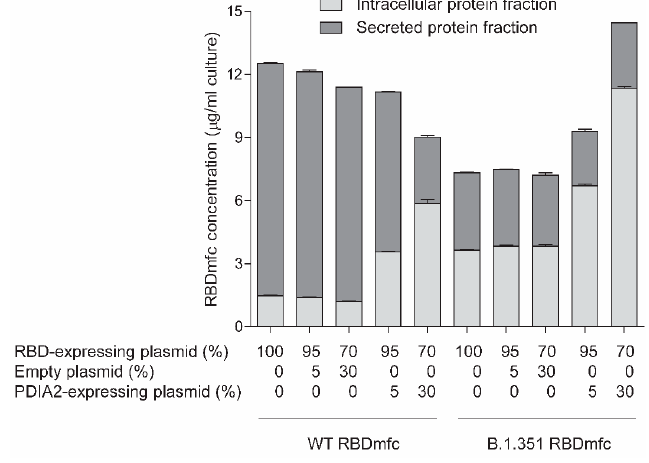
Figure 3. Concentration of intracellular and secreted recombinant RBDmfc proteins upon co-trans- fection of Expi293F cells with PDIA2-expressing or empty vectors. Expi293F cells were transfected with 1 μ g plasmid DNA per ml cell suspension (“100%” thus corresponding to 1 μ g plasmid DNA). In co-transfection experiments, the respective proportion of plasmid expressing RBDmfc, PDIA2 or empty plasmid (to complete to 1 μ g plasmid DNA) is indicated below each bar. Accordingly, 100%, 95%, 70% or 5% plasmid DNA indicates that 1, 0.95, 0.7 or 0.05 μ g plasmid DNA (per ml cell sus-